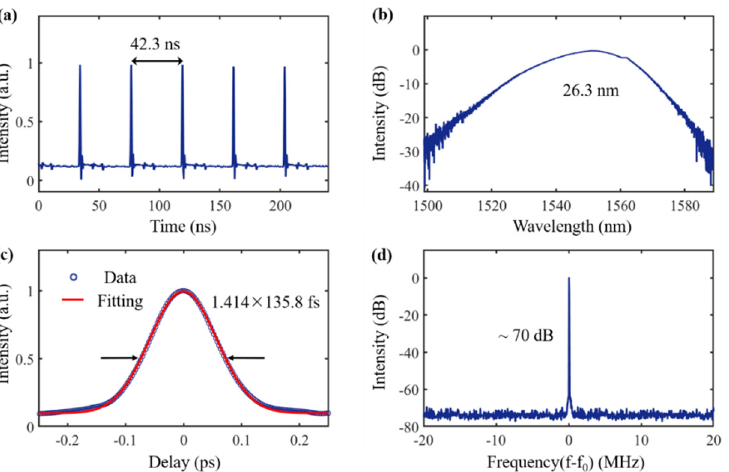
Figure 5. Pulsed output performance of GDY-SA-based erbium-doped mode-locked fiber laser ( a ) typical pulse output sequence with a time interval of 42.3 ns; ( b ) spectrum with a center wavelength of 1551.2 nm and a 3 dB bandwidth of 26.3 nm; ( c ) autocorrelation and Gaussian fit of the output pulse with a pulse width of 135.8 fs; ( d ) RF spectrum with ~70 dB signal-to-noise ratio.